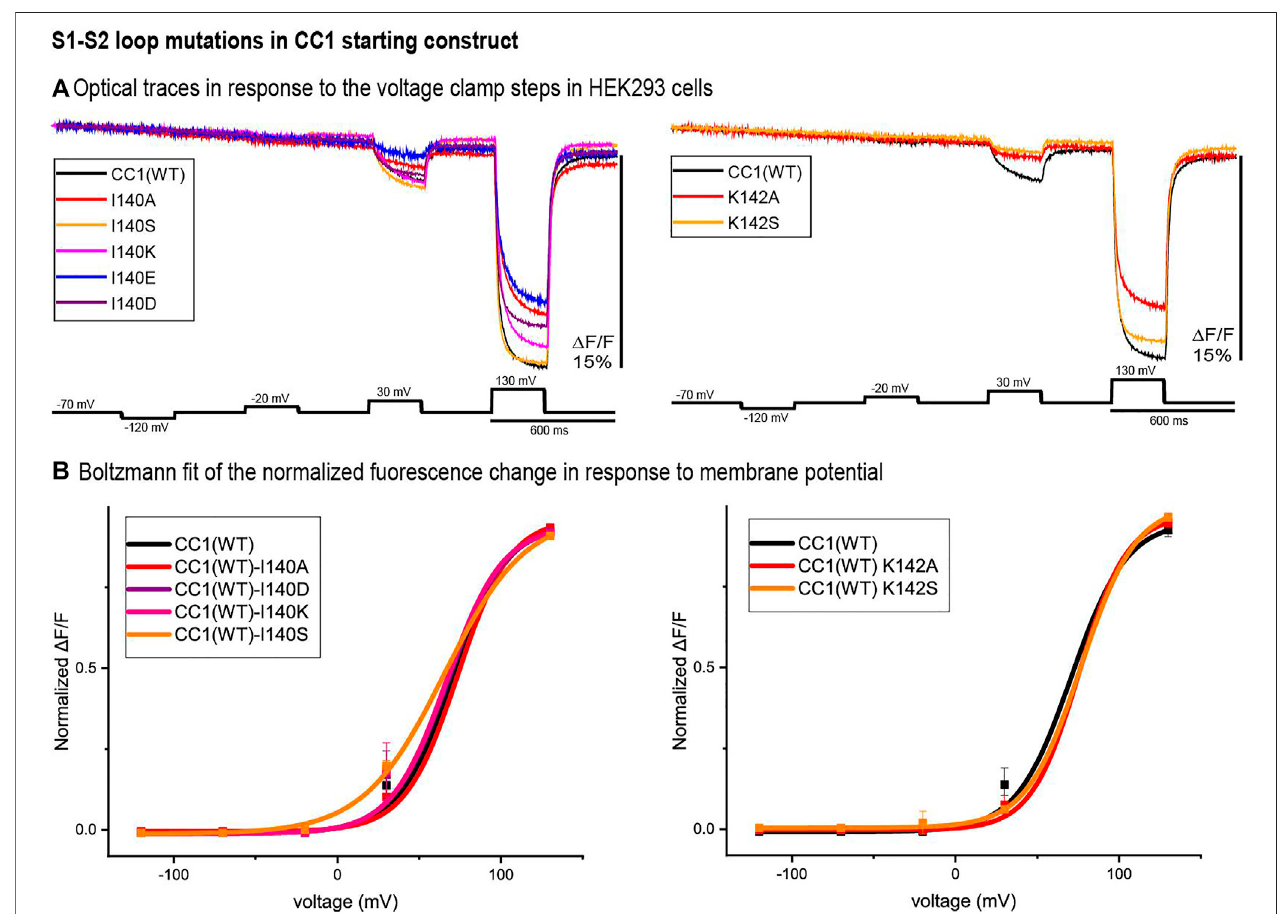
FIGURE 2 | S1-S2 loop mutations in the CC1 starting construct. (A) . The traces are representative fl uorescent signals from voltage-clamped HEK293 cells (averageof16trialsforeachcell)expressingCC1(WT)orCC1withanS1-S2loopmutant.Eachtraceistheaverageofthreecells.Theholdingpotentialwas − 70mV.The pulse protocol is given in the black trace and was identical for all constructs. No temporal fi ltering was used for the traces. Images were recorded at a frame rate of 500 fps. (B) . Boltzmann fi t of the normalized fl uorescence change in response to membrane potential ( n = 3 for all constructs).